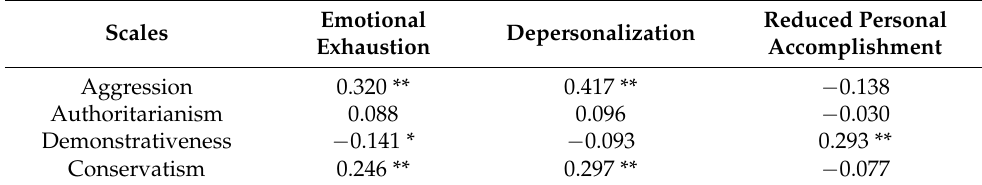
Table 2. The professional burnout—deformation correlation. Reduced Personal Emotional Depersonalization Scales Accomplishment Exhaustion Aggression 0.320 ** 0.417 ** − 0.138 Authoritarianism 0.088 0.096 − 0.030 Demonstrativeness − 0.141 * − 0.093 0.293 ** Conservatism 0.246 ** 0.297 ** −